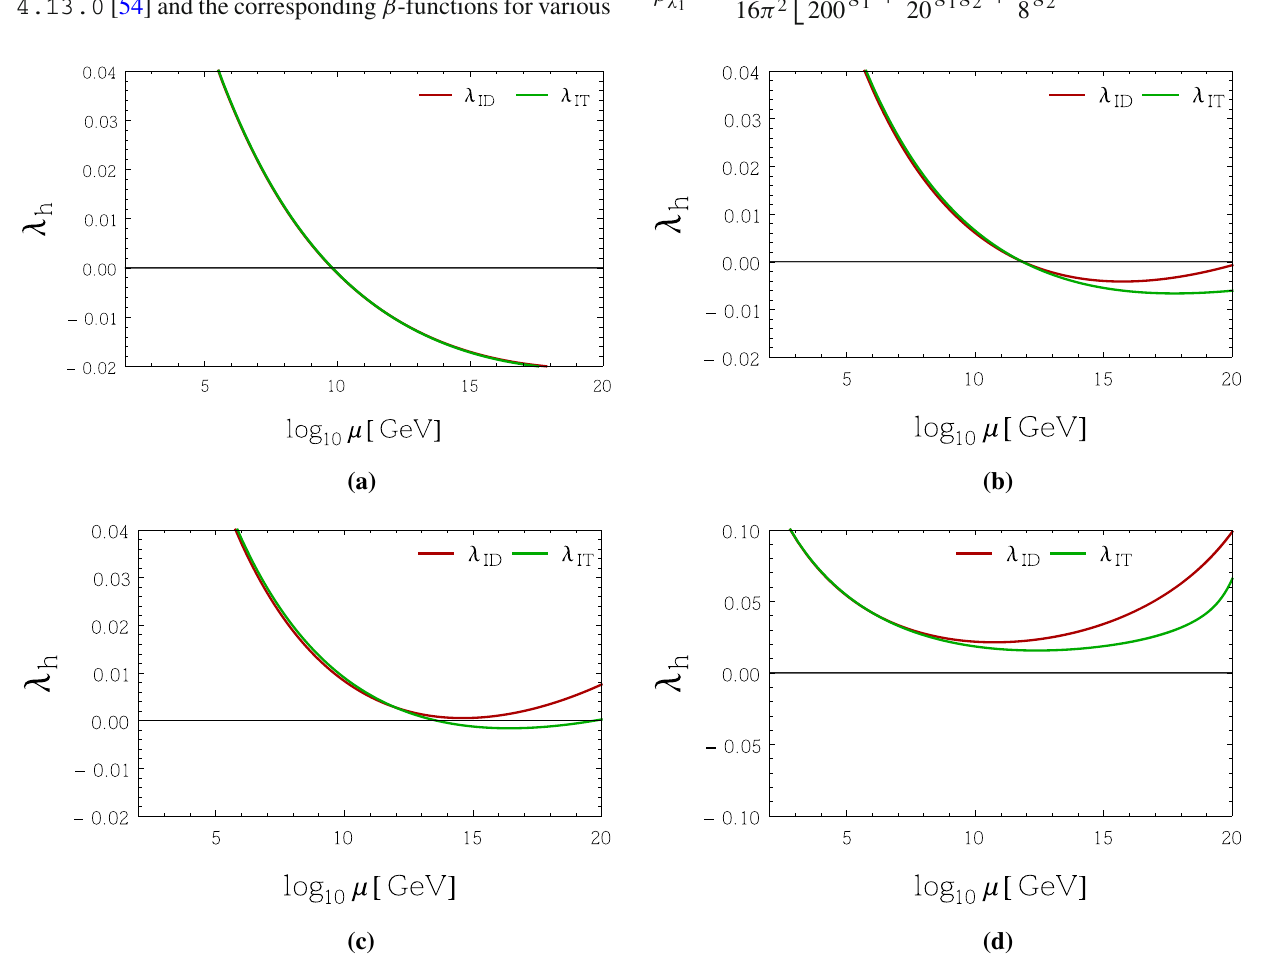
Fig. 6 Two loop running of the SM like Higgs quartic coupling in IDM and ITM for four benchmark values of the Higgs quartic couplings (λ ) in IDM and (λ ) in ITM to be 0.010, 0.060, 0.068 and ht , t 1 = 2 , 3 , 4 , 5